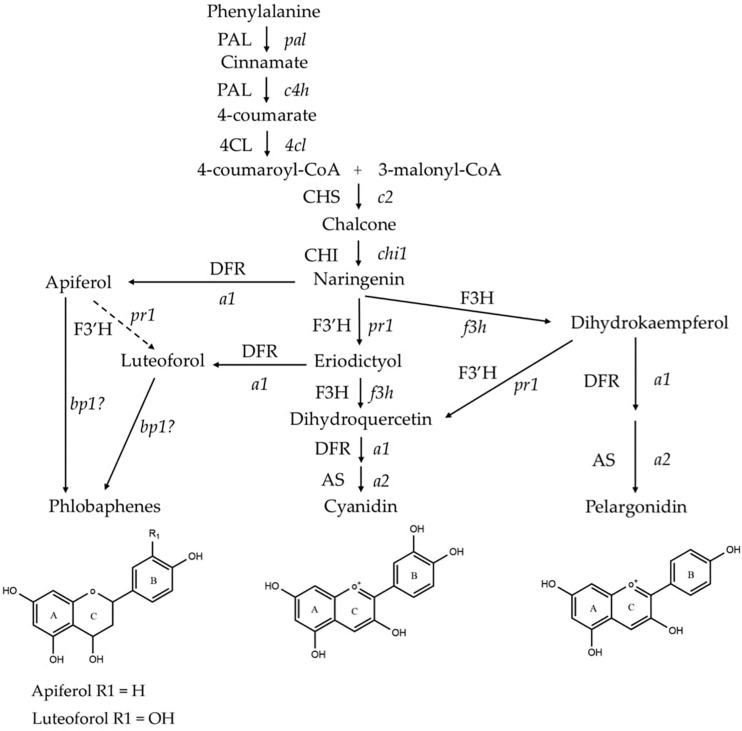
Phenylpropanoid biosynthetic pathway of anthocyanins (cyanidin and pelargonidin) and phlobaphenes in maize. Genes (enzymes) involved in the pathway are: pal (PAL), phenylalanine-ammonia lyase; c4h (C4H), cinnamic acid hydroxylase; 4cl (4CL), 4-coumaryl-CoA ligase; c2 (CHS), chalcone synthase; chi1 (CHI), chalcone isomerase; f3h (F3H), flavanone 3-hydroxylase; pr1 (F3′H), flavonoid 3′-hydroxylase; a1 (DFR), dihydroflavonol reductase; a2 (AS), anthocyanidin synthase; and brown pericarp1 (bp1). (Adapted from Sharma et al., 2011, 2012).